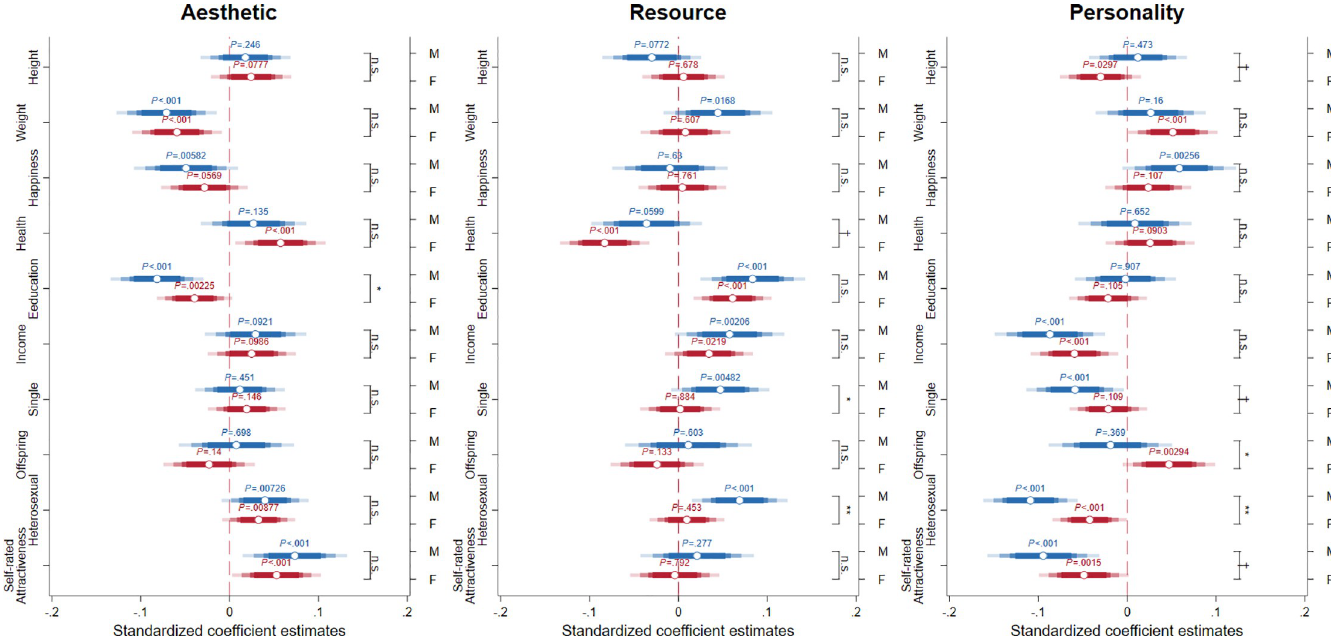
Fig 5. Sex-specific factors on sexual attraction importance of aesthetic, resource, and personality factors. We show the effect of each independent variable on the relative importance of characteristics of interest for both sexes (effects on male and female sexual preferences are indicated by blue and red markers, respectively). P- values of the sex-specific effects are shown above the corresponding markers, with error bars indicating 90%, 95%, 99%, and 99.5% confidence intervals. The statistical significance of the sex difference of each independent variable (i.e., interaction terms with sex) is shown to the right of the coefficient estimates. † p < .10; � p < .05; �� p < .01; ��� p <